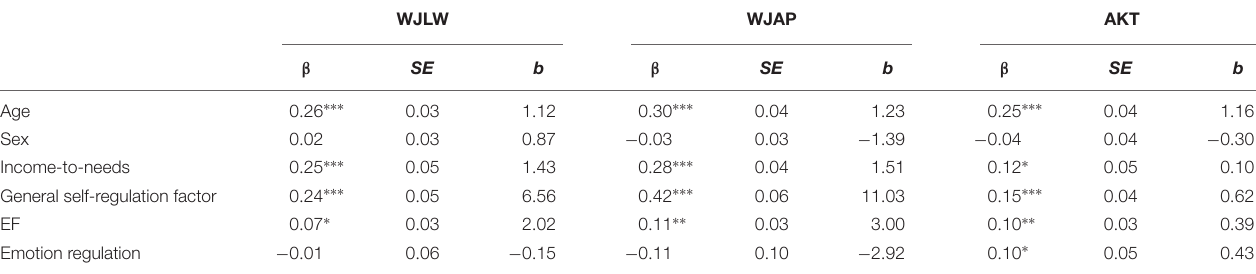
TABLE 3 | Structural equation models between self-regulation factors and academic and social-emotional skills. WJLW WJAP